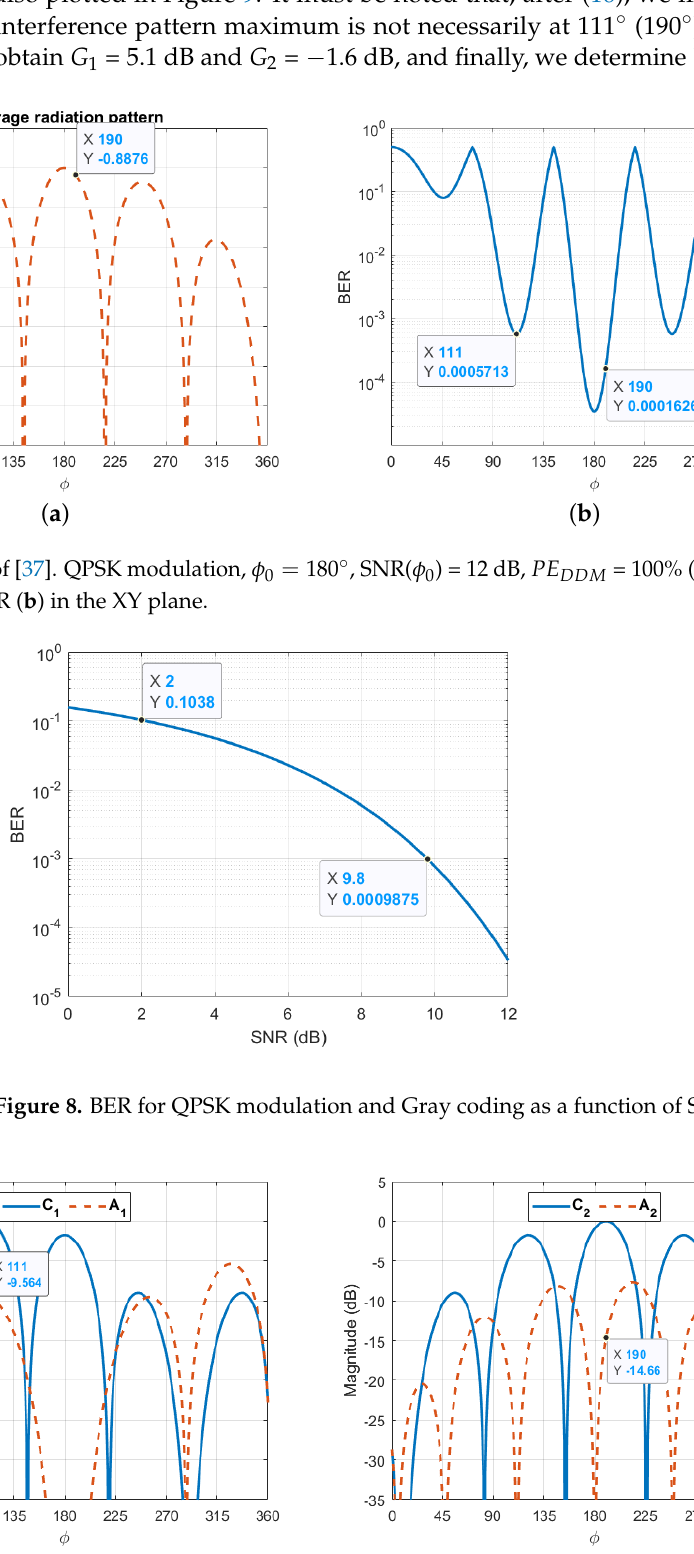
Figure 9. Compact antenna of [37], interference radiation patterns generated by antenna weights C k (15) and A k (16). ( a ) φ 1 = 111 ◦ . ( b ) φ 2 = 190 ◦